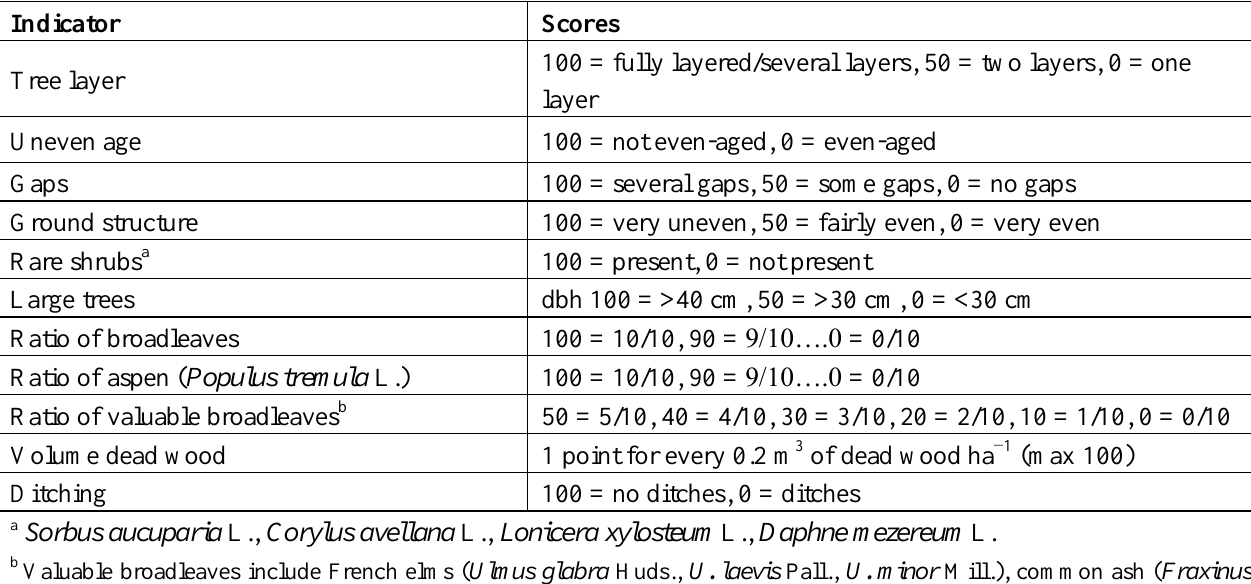
Table 2. Variables used for calculating nature conservation scores